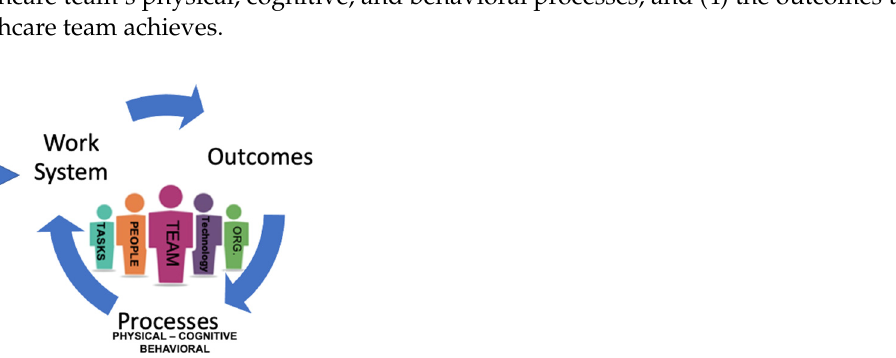
Figure 1. Advanced Decision Making and Systems Engineering for Patient Safety Adapted